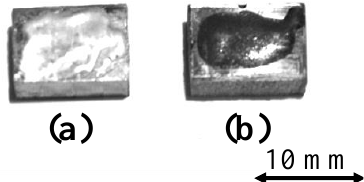
Figure 3. Test pieces with the microspheres (Silica sphere), ( a ) Diameter: 2.0 μm, ( b ) Diameter: 700 nm.